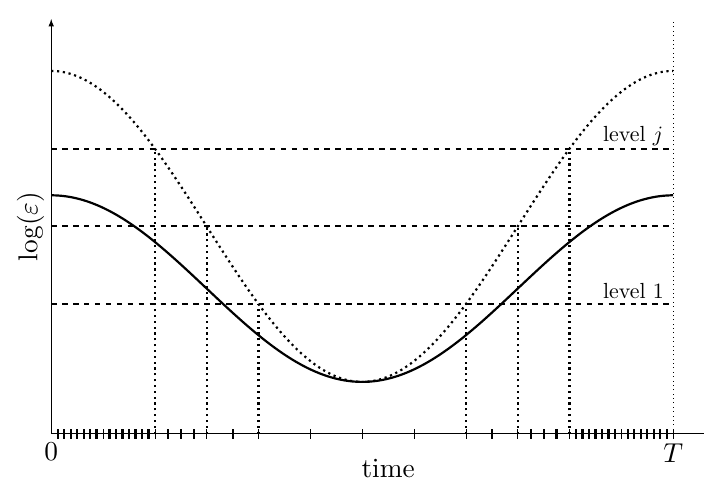
Figure 4. Illustration of the multi-level adaptive time-mesh refinement